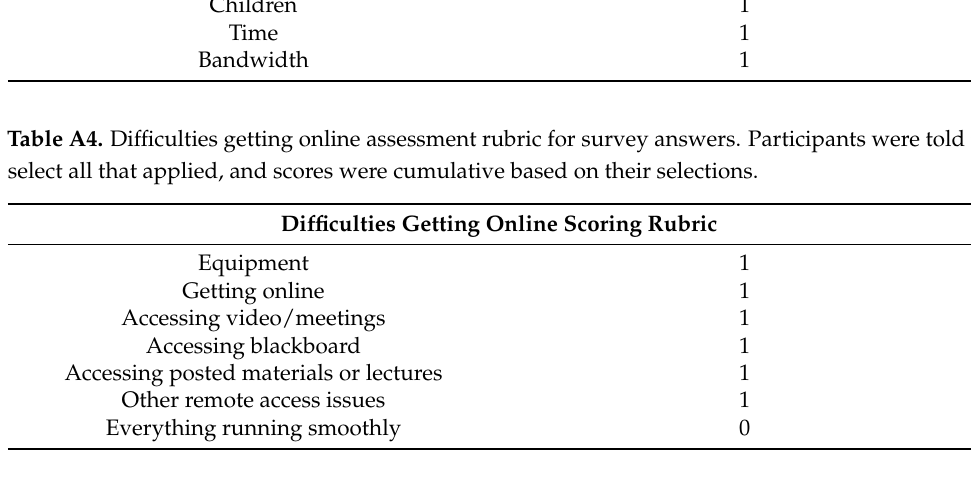
Table A5. Financial issues assessment for survey answers. Participants were told to select all that applied, and scores were cumulative based on their selections.